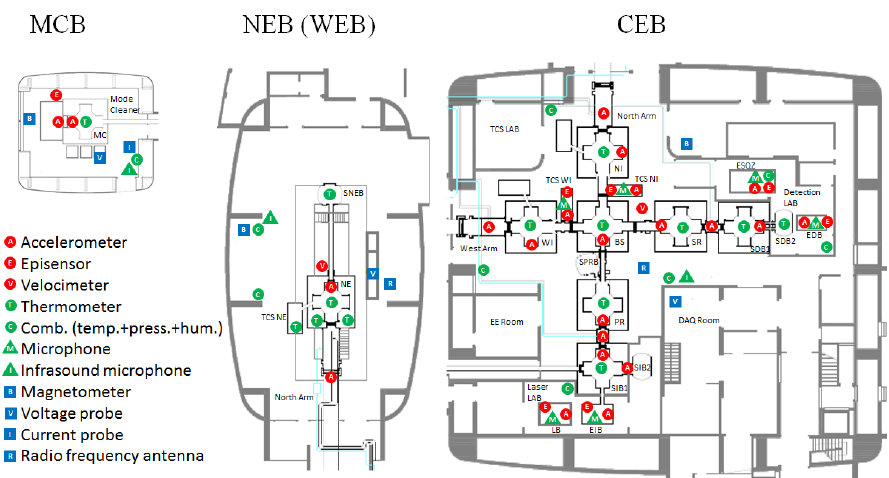
Figure 2. Virgo environmental probes. Top left: mode cleaner building (MCB). Middle: North end building (NEB). West end building (WEB) is identical. Right: central building